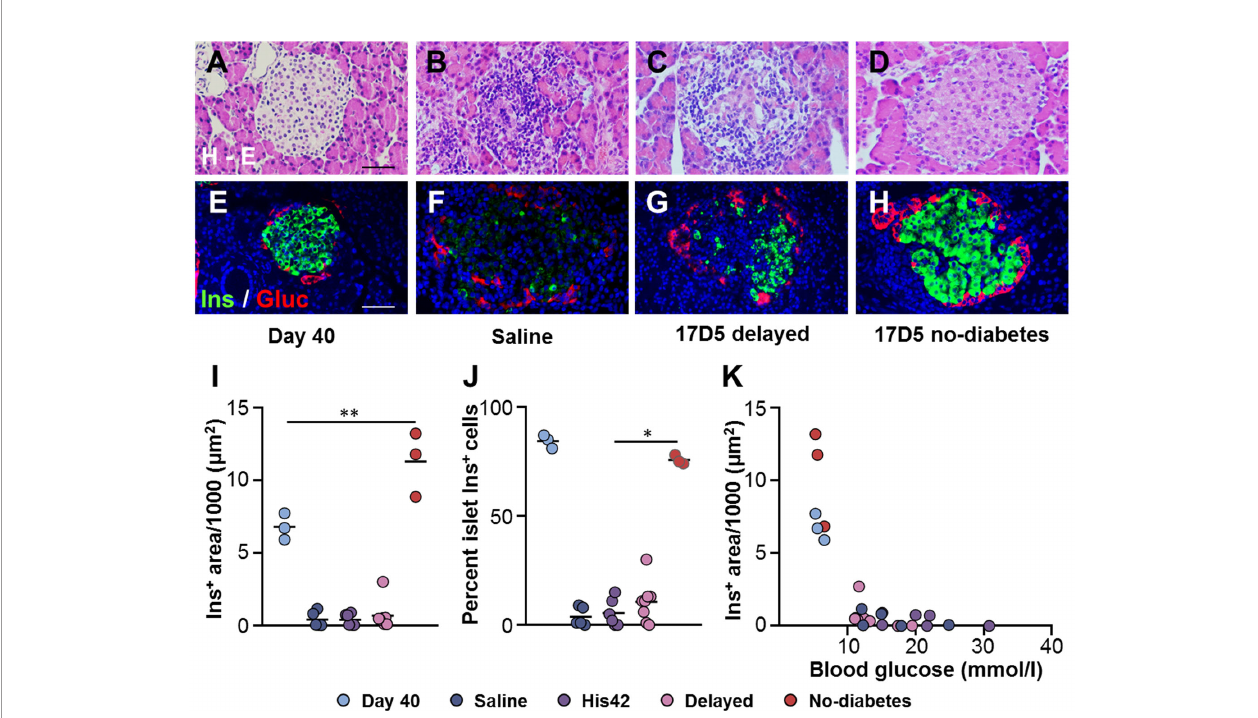
FIGURE 2 | Preservation of islet morphology in the 17D5-no diabetes DR Lyp/Lyp rats. (A – D) Hematoxylin-Eosin (H-E) staining in pancreas tissues from rats in the indicated groups. (E – H) Immunohistochemistry for insulin (Ins, green) and glucagon (Gluc, red). Scale bars, 50 µm. To avoid redundancy, images from His42-treated rats are not shown. (I) Morphometric quanti fi cation of islet Ins+ areas. (J) Relative proportion of islet Ins+ cells. (K) Ins+ areas plotted as a function of blood glucose levels. Each circle denotes an individual rat; dark slate blue, saline (n = 5); purple, His42 (n = 6); pink, 17D5 delayed (n = 8); red, 17D5 no-diabetes (n = 3); light slate blue, 40 day old (n = 3). Data are mean values of measurements obtained for each rat. The solid horizontal lines in (I, J) indicate the mean of the measurements in each group. * P < 0.05, 17D5 no-diabetes vs saline, His42, or 17D5 delayed; ** P < 0.01, 17D5 no-diabetes vs saline, His42, 17D5 delayed, or day 40; Mann- Whitney U